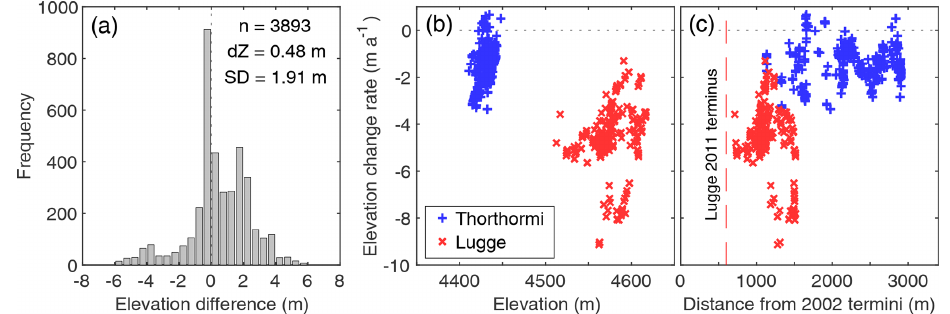
Figure 2. (a) Histogram of elevation differences over off-glacier area at 0.5m elevation bins. The rate of elevation change for Thorthormi (blue) and Lugge (red) glaciers is compared with (b) elevation in 2011, and (c) distance from the glacier termini in 2002 along the central flow lines (Fig. 1b). The dashed red line in (c) denotes the location of the calving front of Lugge Glacier in